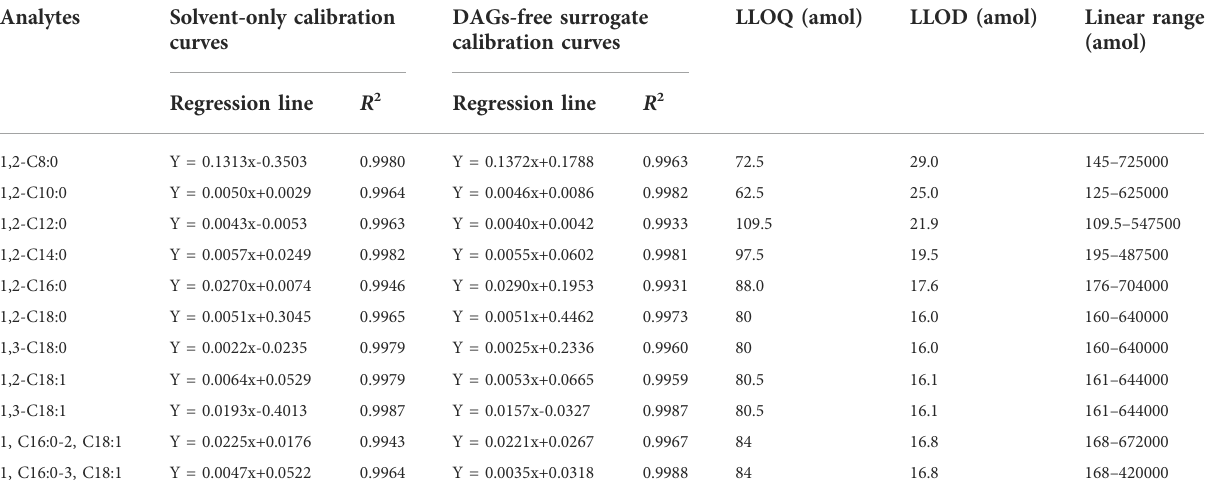
TABLE 1 Calibration curves and LODs for the analysis of DMG